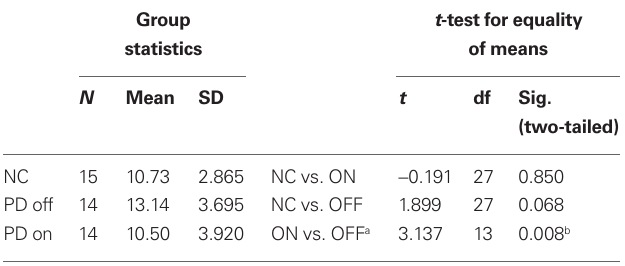
Table 3 | Number of reversals achieved on the reversal learning task. Group